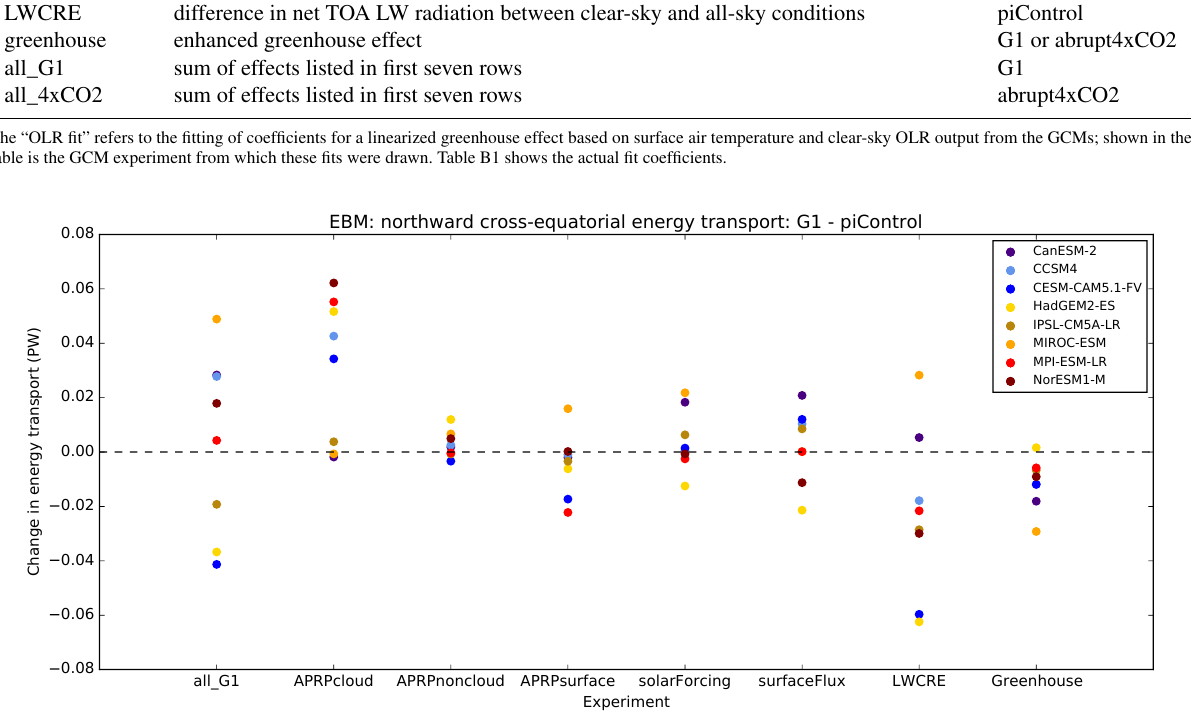
Figure 6. Changes in northward cross-equatorial energy transport calculated by moist EBM for G1 – piControl in various attribution experi-